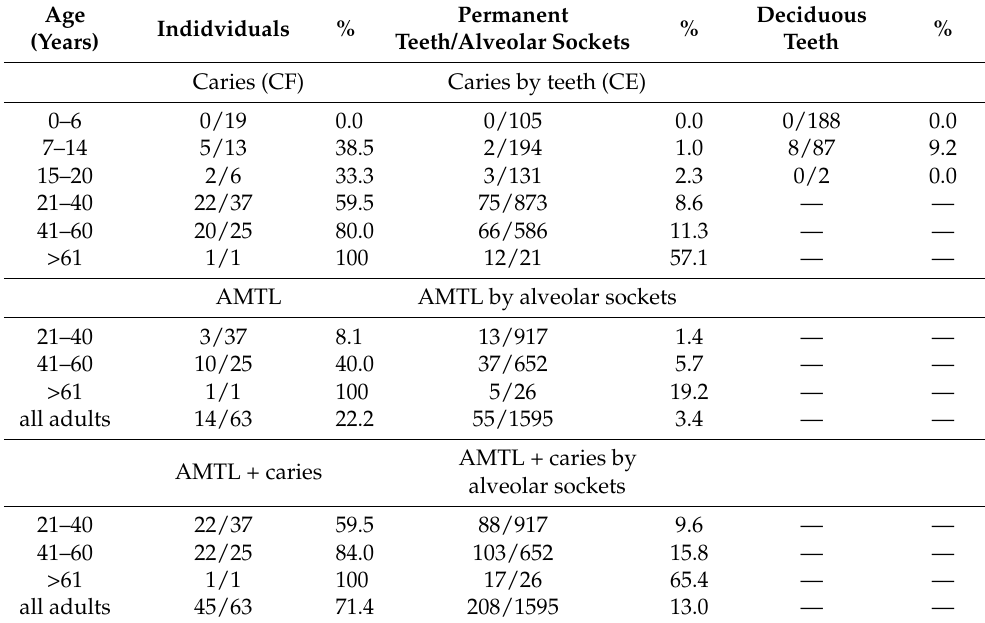
Table 3. Caries frequency (CF) and caries experience (CE) in subadult and adult individuals from all sites by age group, with data on permanent teeth and deciduous teeth affected. Data on AMTL and AMTL combined with caries are given by adult individuals and assessable alveolar sockets. Deciduous Permanent Age % % Indidviduals % Teeth Teeth/Alveolar Sockets (Years) Caries (CF) Caries by teeth